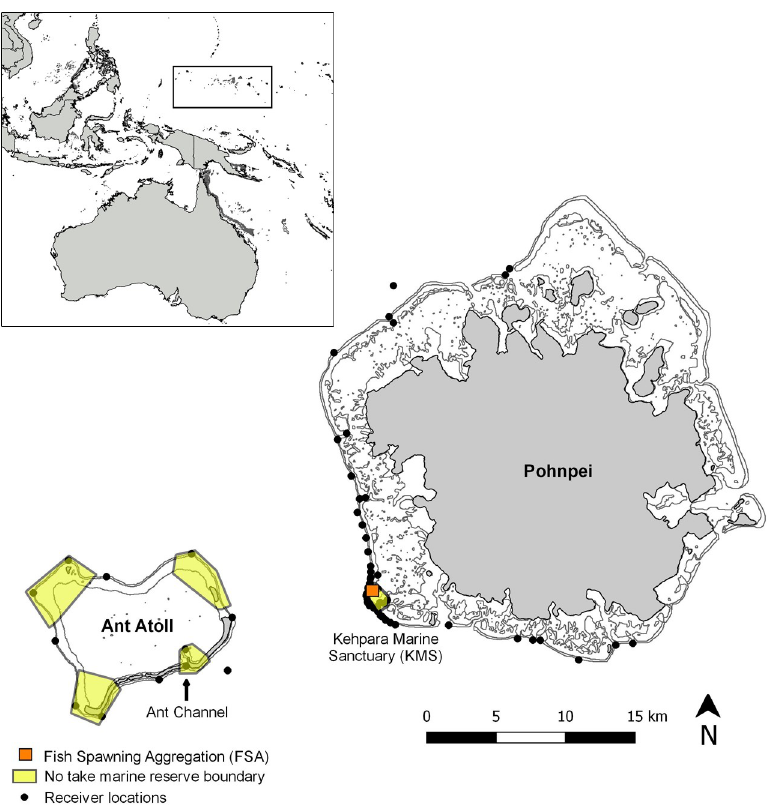
Fig 1. Map of the study site. Pohnpei and Ant Atoll, Federated States of Micronesia showing receiver locations. Boxes with yellow shading indicate the boundaries of no-take marine reserves and land masses are shaded grey. Orange boxes denote fish spawning aggregation (FSA)